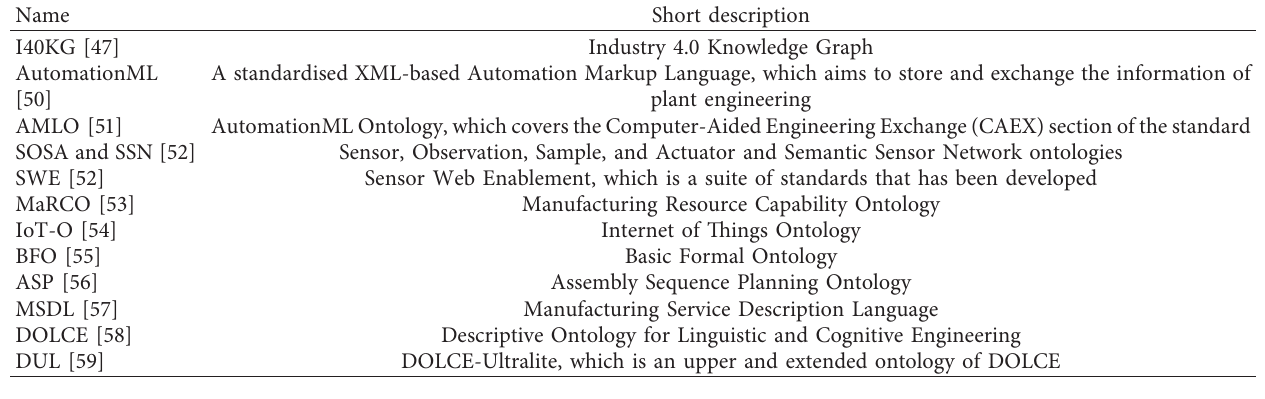
Table 1: List of the most relevant ontologies and description methods in manufacturing.